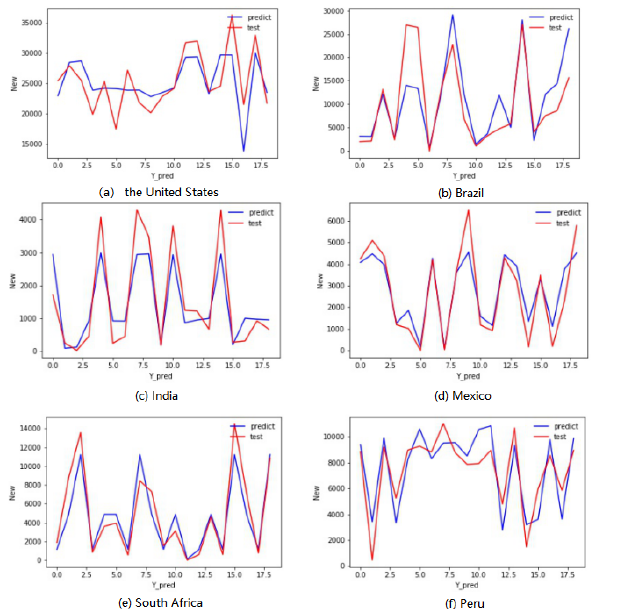
Figure 1. Comparison of test sets and model predictions in Different